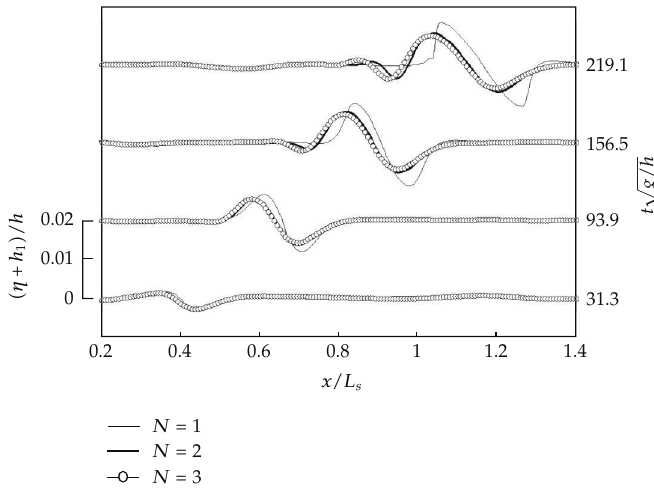
Figure 14: Time variation of interface profiles due to the point load moving on the floating thin plate, where η is interface displacement; κ (cid:7) 1.0; N (cid:7) 1, 2, and